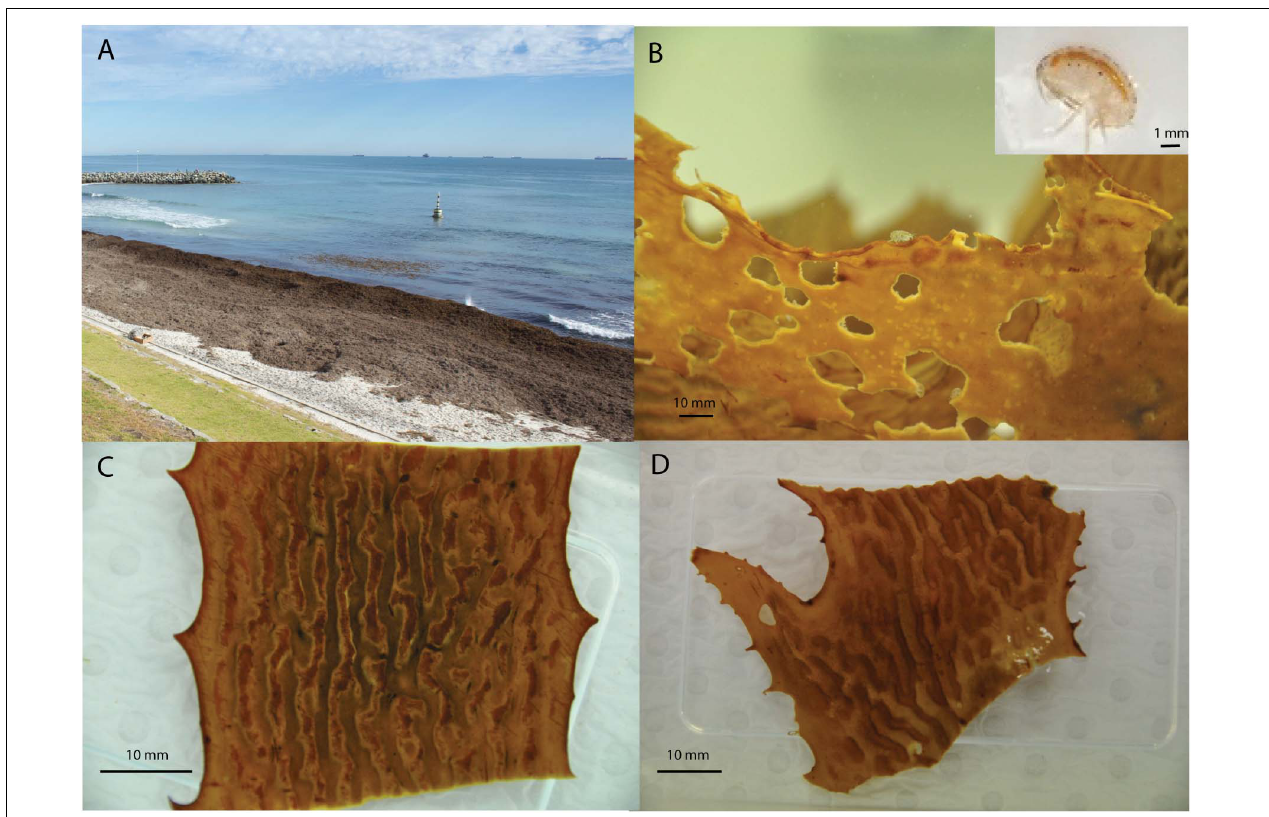
FIGURE 1 | (A) Wrack in the surf zone and on the beach in south-western Australia; (B) the amphipod Allorchestes compressa (inset) feeding on the kelp Ecklonia radiata and its biofilm; and examples of the levels of biofilm on experimental pieces of kelp which (C) had not been subjected antiobiotic treatment and (D) had been treated with